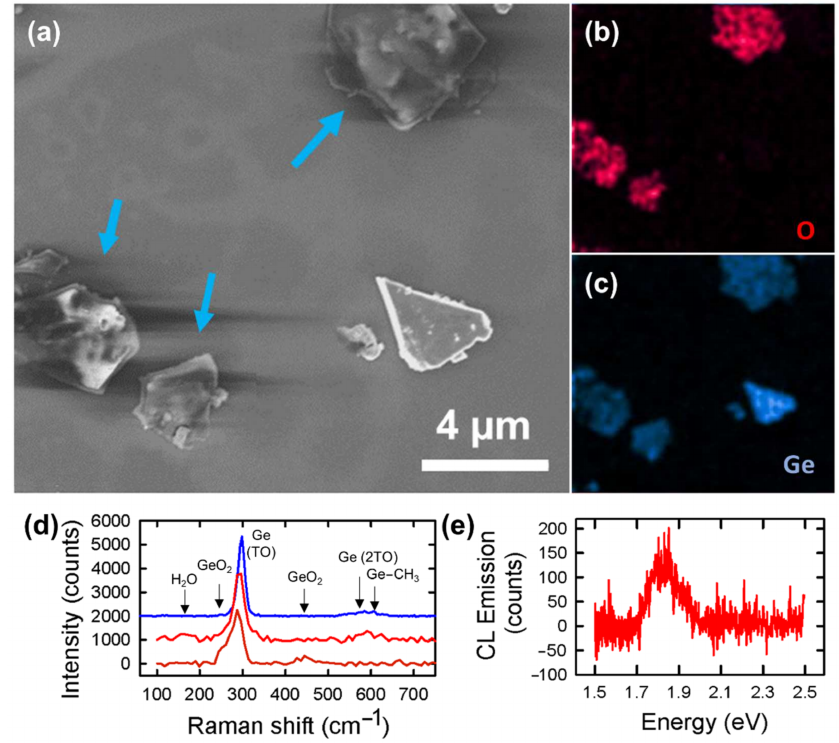
Figure 2. ( a ) SEM image of methyl-terminated germanane and corresponding energy-dispersive X-ray spectroscopy elemental mappings for ( b ) oxygen and ( c ) germanium. Blue arrows delineate microcrystallites that exhibit charging under electron irradiation. ( d ) Raman spectroscopy measured in the SEM setup of oxidized (bottom), hydrated (middle), and dehydrated (top) methyl-terminated germanane microcrystallites. The vertical arrows delineate the positions of vibrational modes of Ge (TO: transverse optical phonon mode), GeO 2 , and H 2 O. ( e ) Cathodoluminescence spectroscopy of a hydrated methyl-terminated germanane